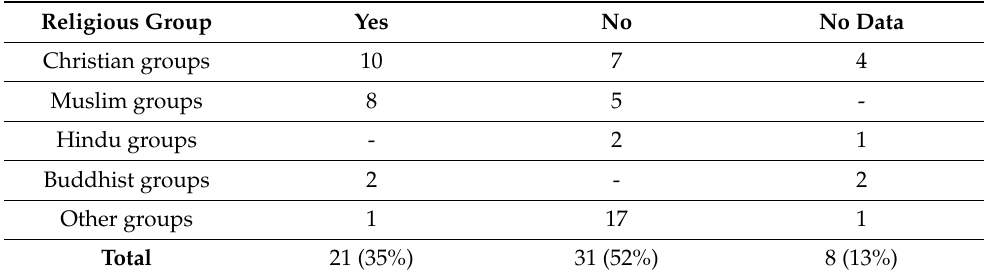
Table 3. Research question 3: Have you offered non-religious, charitable services to lay members during the crisis (e.g., grocery shopping, dog walking)?